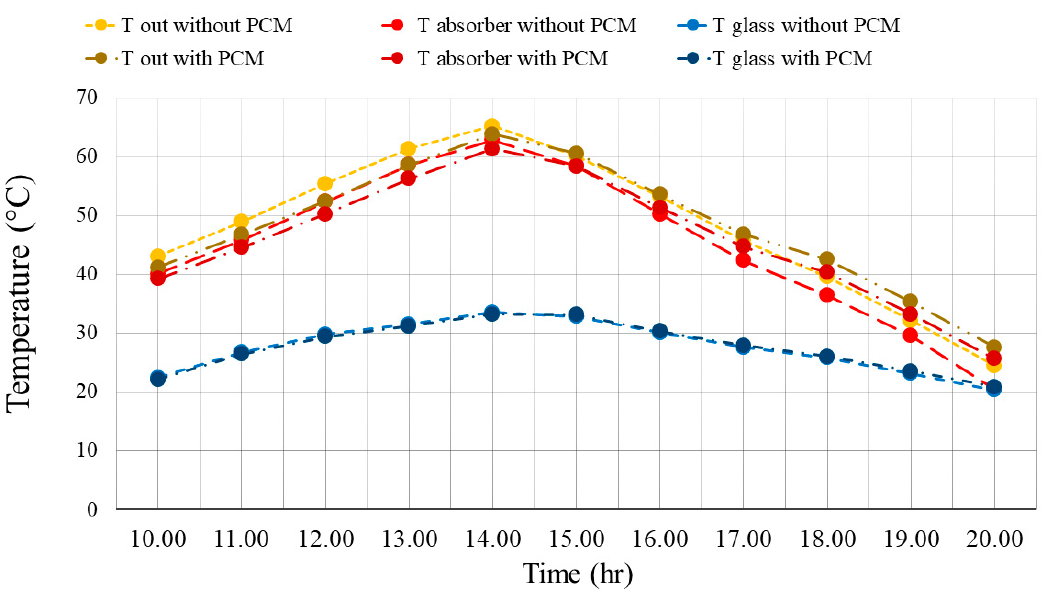
Figure 7. The TEM in three parts of the wall, including the outlet, the absorber plate, and the glass at different times of the day with and without PCM in the winter.